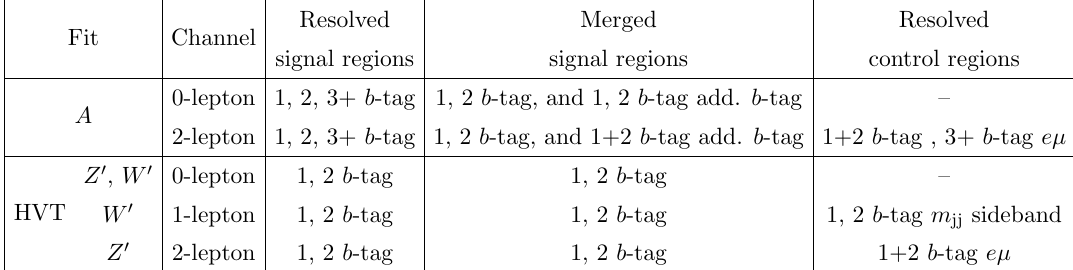
Table 4. A list of the signal and control regions (separated by commas below) included in the statistical analysis of the A and HVT model hypotheses. The notation 1+2 b -tag indicates the 1 and 2 b -tag regions are combined, and add. b -tag indicates the regions with additional b -tags not associated with the large- R